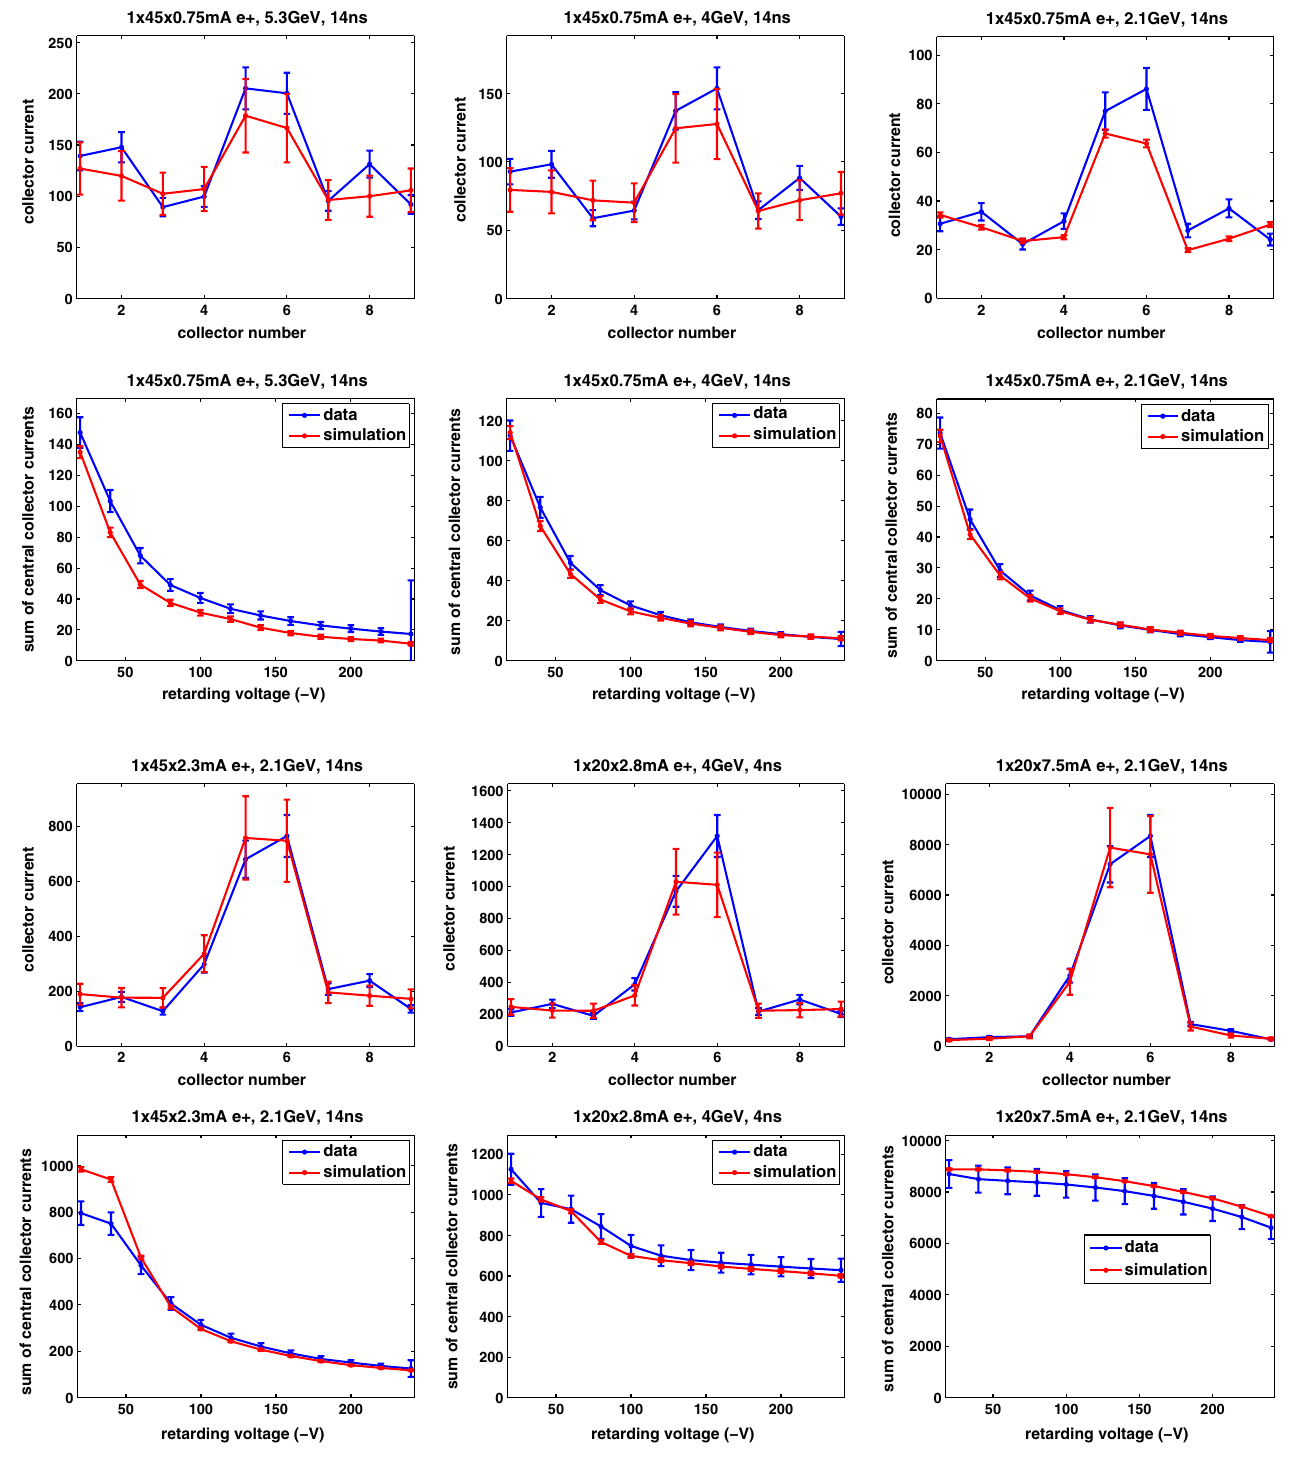
FIG. 7. Comparison of Q15WAl RFA data and simulation, using best fit parameters (Table VII), conditions 1 – 6 (Table VI). The RFA is “ thin ” style (Table II). The top plots show the total signal across the 9 RFA collectors (with þ 50 V on the grid); the bottom plots show the signal in the central three collectors vs retarding